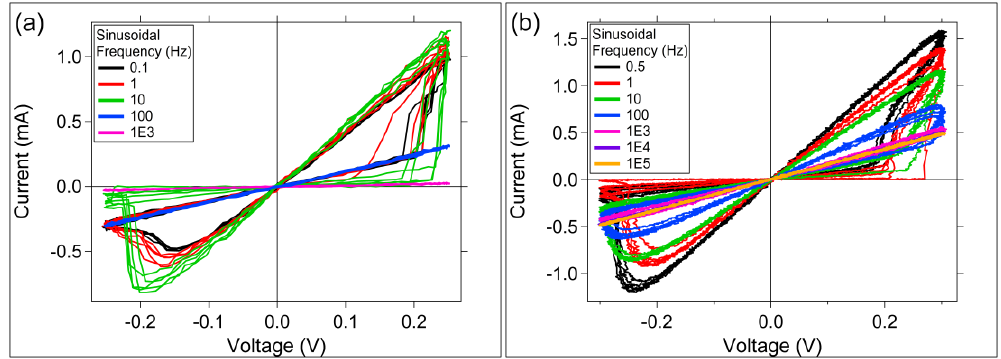
Figure 7. Cu and Ag device response to a sinusoidal input with varying frequency. ( a ) Cu device; ( b ) Ag device. T = 300 K. Six cycles at each frequency are shown.